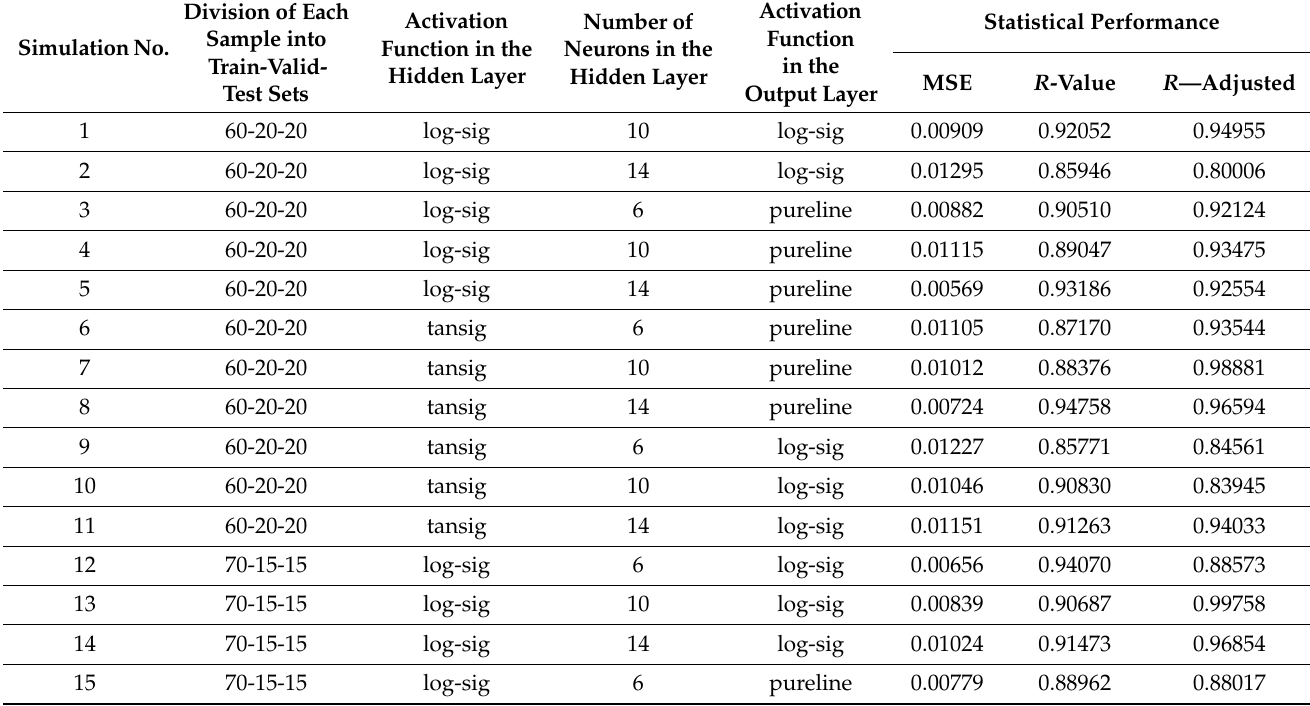
Table 4. Optimization of the neural network